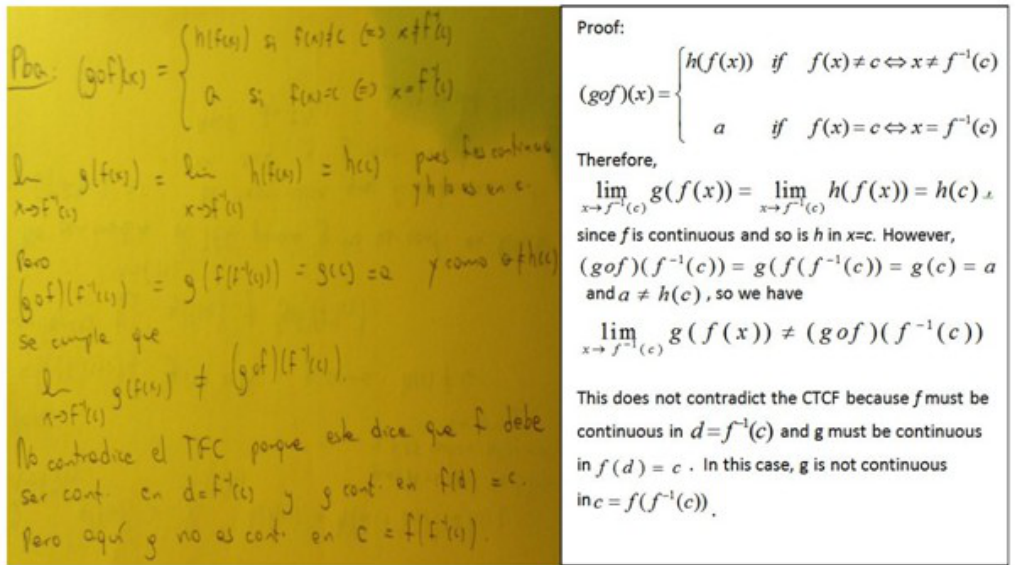
Figure 9. Generalizaton of the original problem by a group of